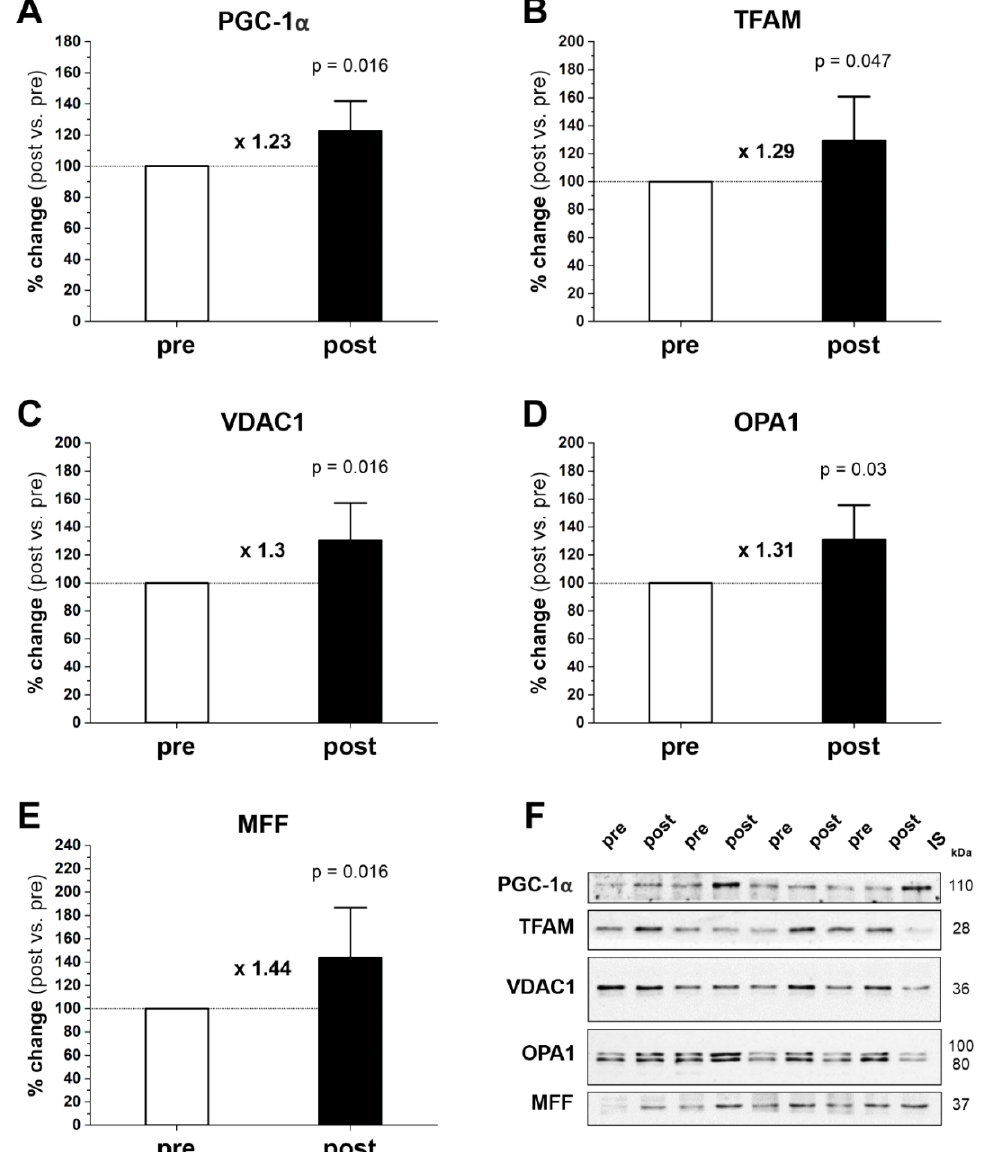
Figure 2. Effect of 20-week endurance training on the protein level of PGC1- α ( A ), TFAM ( B ), VDAC1 ( C ), OPA1 ( D ), and MFF ( E ) in human gastrocnemius muscle. Representative Western blots of 4 subjects and analysis of protein expression are shown ( F ). The internal standard (IS) is a human vastus lateralis muscle sample. The results are expressed as the percentage change after training (post) in relation to the status before training (pre), which is presented in the graph as 100%. Data are presented as the mean ± SD. The nonparametric Wilcoxon sign rank test with a two-sided p-value is shown. Post- vs. prefold changes defined as the ratio of post-training value to pretraining value are marked as a multiple of the change, e.g., ×1.23 is a 1.23-fold increase. Blot fragments are shown (framed). The entire blots and corresponding Ponceau detections are shown in Supplementary Figures S1 – S5.